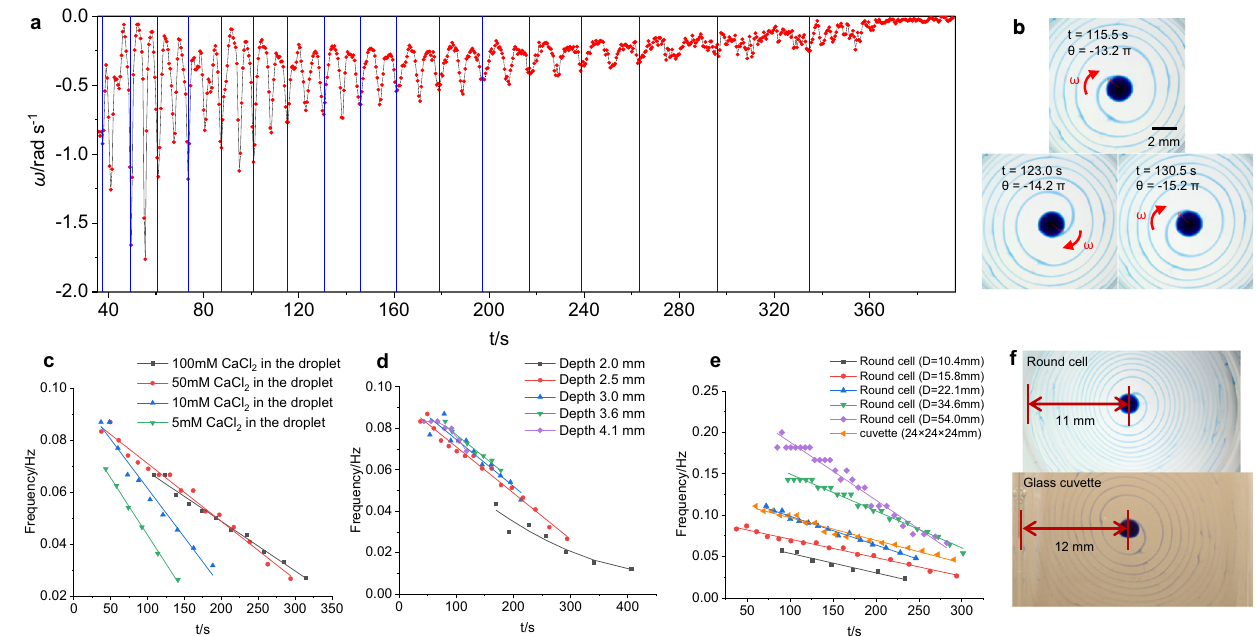
Fig. 5 | Effect of CaCl 2 concentration in the droplet, solution depth, and con- tainer size on the frequency of spiral patterns. a Angular velocity curve ω ( t ) obtainedbytrackingtherotationofthe fi lamentinaroundcell(diameter15.8mm) fi lled with PEG-SDBS (2.5mM) solution (depth 2.5mm) (Supplementary Movie 3). The ω data were recorded every 0.5s. ω <0 because the rotation was clockwise. b Corresponding images for the three peaks in the ω ( t ) curve at 115.5 ( θ = − 13.2 π ) , 123.0 ( θ = − 14.2 π ) , and 130.5s ( θ = − 15.2 π ) , respectively. c f r ( t ) curve measured for the addition of a 1 μ L droplet of DEX-MB-CaCl 2 containing 100 (black line), 50 (red line), 10 (blue line), and 5 (green line) mM of CaCl 2 to a round cell (diameter 15.8mm) fi lled with PEG-SDBS (2.5mM) solution (depth 2.5mm), respectively.